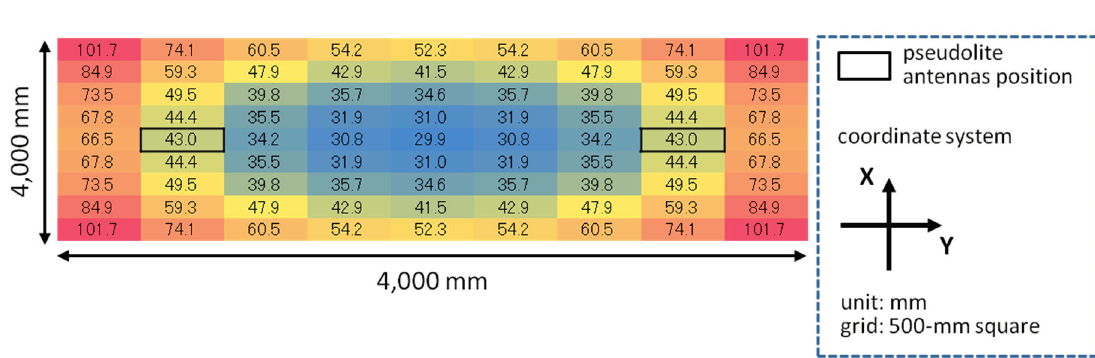
Figure 13. Three-dimensional positioning error with double array based on CPD bias error (9.2 mm).